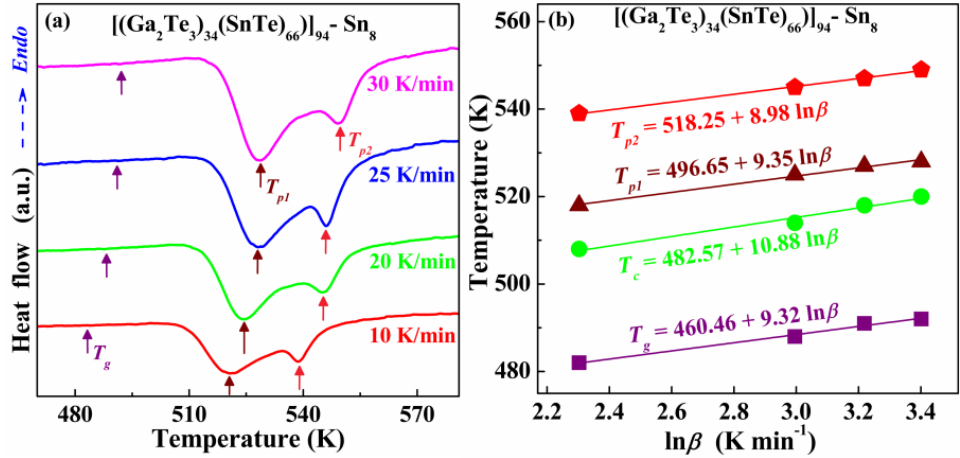
Figure 3. ( a ) Non-isothermal DSC curves at different heating rates (10, 20, 25 and 30 K/min) and ( b ) the relationship between characteristic temperatures T g , T c , T p 1 and T p versus ln( β ) of the S8 amorphous samples.